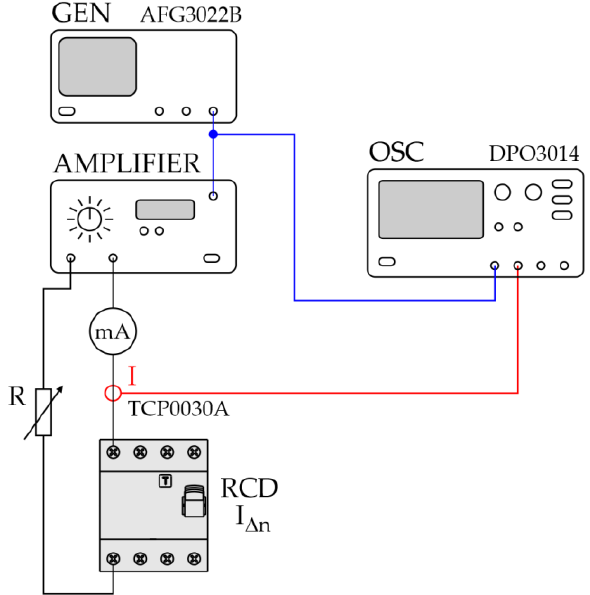
Figure 6. Diagram of the measurement system (option 2) for determining the RCD break time for different initial phases of the differential current.